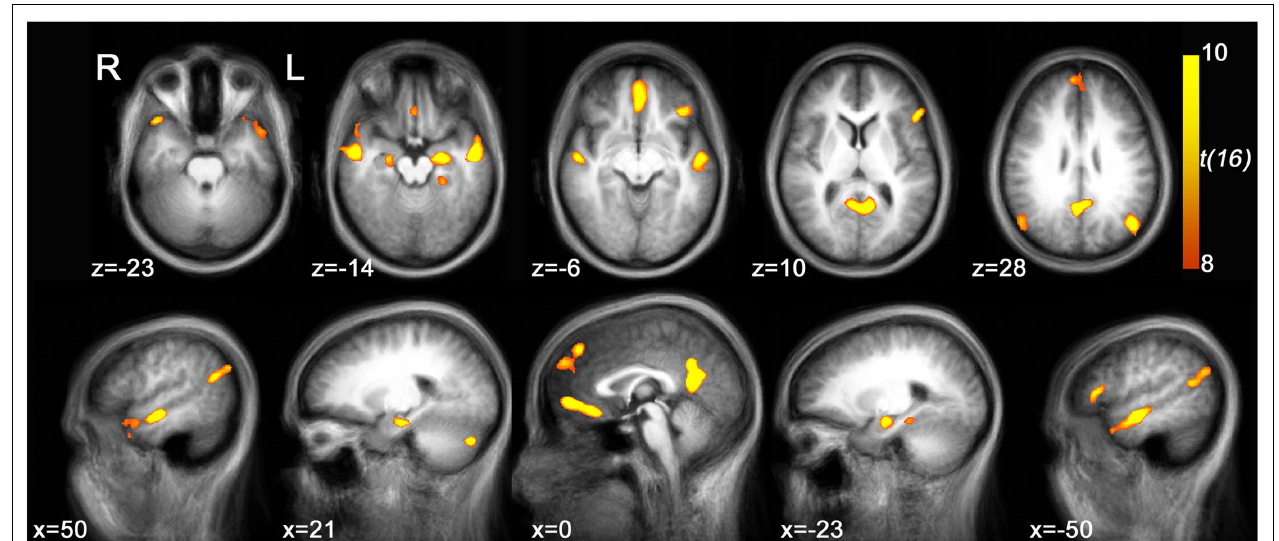
Activity is observed in left parahippocampal gyrus (PHG), bilateral hippocampal complex (HPC), bilateral superior temporal sulcus (STS), right temporal pole (TP), bilateral angular gyrus (AnG), medial posterior cortex (including posterior cingulate cortex and precuneus), ventromedial prefrontal cortex (VMPFC), left